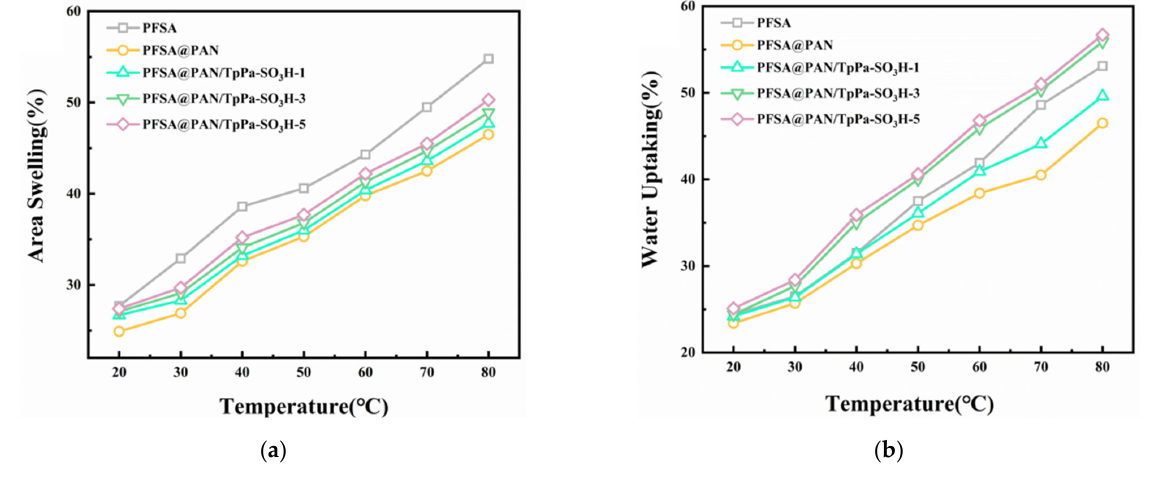
Figure 6. ( a ) Area swelling and ( b ) water uptaking of membranes at 100% RH from 20 °C to 80 °C.